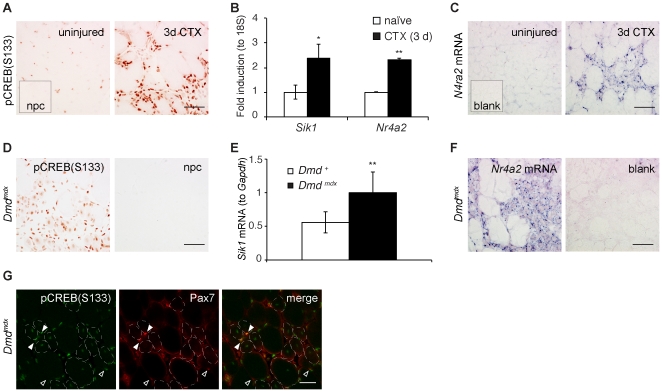
CREB is activated by muscle injury.A) Immunohistochemistry with anti-pCREB(S133) antibody shown on uninjured and injured contralateral muscles 3 days after cardiotoxin (CTX) injection; inset, no primary antibody control (npc). B) CREB target gene mRNAs Sik1 and Nr4a2 in mouse gastrocnemius muscle 3 days after CTX injection. Relative mRNA amounts to 18 S rRNA, normalized to naïve muscle. n = 2 naïve, 3 CTX. * p<.05, ** p<.01. Similar data were obtained on an independent cohort. C) In situ hybridization with Nr4a2 antisense riboprobe on uninjured and 3 day CTX-injected contralateral legs; no riboprobe control (blank, inset). D) Phospho-CREB immunohistochemistry and npc on gastrocnemius muscle from a 4-week old Dmdmdx mouse. E) Sik1 mRNA in wild-type and Dmdmdx gastrocnemius tissue from 4-week old mice. mRNA normalized to Gapdh, averaged by genotype (±stdev); n = 6 WT, 6 Dmdmdx; ** p<.01. F) In situ hybridization with antisense Nr4a2 riboprobe or blank (control) on Dmdmdx gastrocnemius at 4 weeks of age. G) Immunofluorescence staining of Dmdmdx gastrocnemius (4 wk) showing pCREB (green), Pax7 (red) and merge. Filled arrowheads, co-localized Pax7 and pCREB; open arrowheads, Pax7-positive nuclei without high pCREB; dotted circles, centrally nucleated myofibers. Bars, 50 µm (A, C, D, F), 10 µm (G).